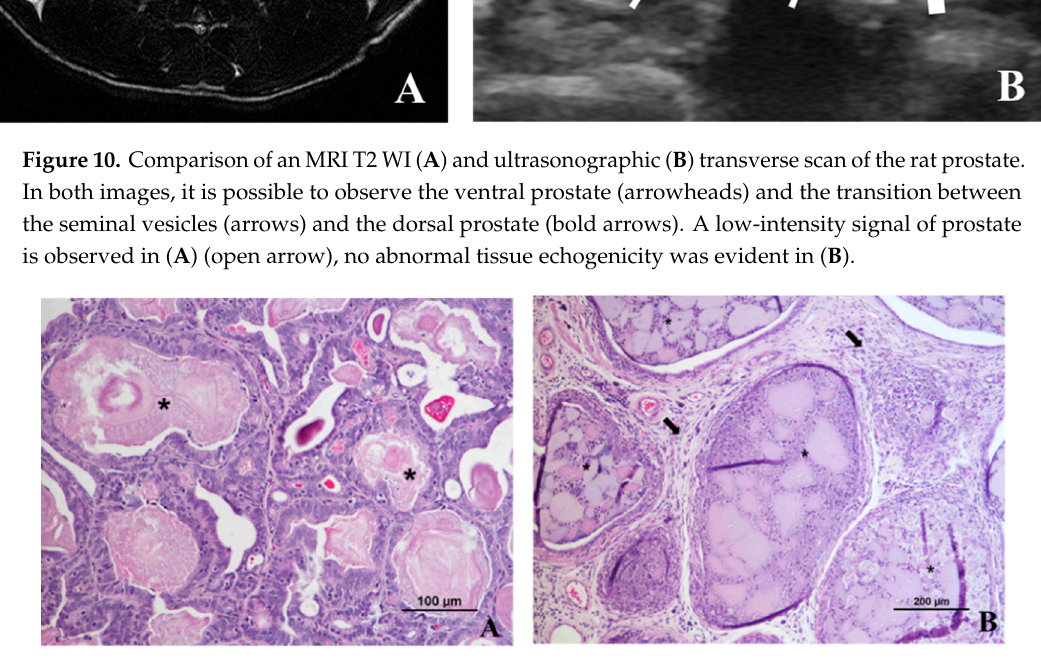
Figure 11. Microscopic appearance of abnormal rat seminal vesicles and prostate at 61 weeks of age in prostate cancer induced group. ( A ) Enlarged seminal vesicle showing corpora amylacea (*); ( B ) Dorsolateral left prostate lobe showing extensive necrosis, acute acini inflammation (*) and chronic stromal inflammation with fibrosis (arrow) (see normal dorsal and lateral prostate lobes in Figure 2B, F). ( C ) Seminal vesicle mural atrophy and presence of a papillary adenoma (*). 7. Conclusion This work provides a description of the macroscopic and microscopic anatomy of the rat prostate, and its imaging by ultrasonography, CT and MRI. Both ultrasonography and MRI allow for a comprehensive and detailed study of the rat prostate and seminal vesicles, and are recommended for the study of prostate anatomy and for the monitoring of prostate diseases such as cancer. MRI show high sensitivity for detecting and delimiting abnormal prostatic tissue. The CT showed limitations in differentiation of internal prostate zones, eventually with different abnormal tissue even in contrast-enhancement studies. Author Contributions: P.A.O., M.F. and R.F. were responsible for the conception and design of the work. M.G., J.M.G.-O., A.I.F.-R., P.A.O., F.S., M.C.-C, M.J.P. acquired the data. A.I.F.-R., M.G., P.A.O., F.S. analyzed and interpreted the data. All authors contributed to manuscript writing and approved the final document. Funding: This research was funded by National Funds by FCT—Portuguese Foundation for Science and Technology, under the project UID/AGR/04033/2019 and FEDER/COMPETE/POCI—Operational Competitiveness and Internationalization Program, under Project POCI-01-0145-FEDER-016728 and National Funds by FCT—Portuguese Foundation for Science and Technology, under the project PTDC/DTP- DES/6077/2014. Acknowledgments: The authors are grateful for the financial support of Lígia Bento concerning prostate tissue processing. Conflicts of Interest: The authors declare no conflict of interest. The funders had no role in the design of the study; in the collection, analyses, or interpretation of data; in the writing of the manuscript, or in the decision to publish the results. References